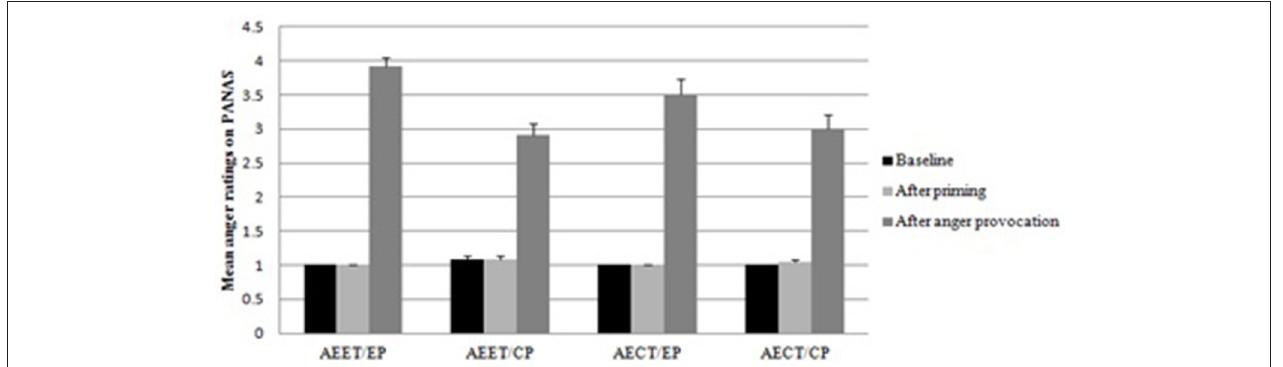
FIGURE 1 | Mean anger ratings in the adapted vision of the PANAS for the four groups (AEET/EP, automatic emotion expression tendency/expression priming; AEET/CP, automatic emotion expression tendency/control priming; AECT/EP, automatic emotion control tendency/expression priming; AECT/CP, automatic emotion control tendency/control priming) across the three measurement points (baseline, after priming, after anger provocation; error bars represent standard errors of the mean).